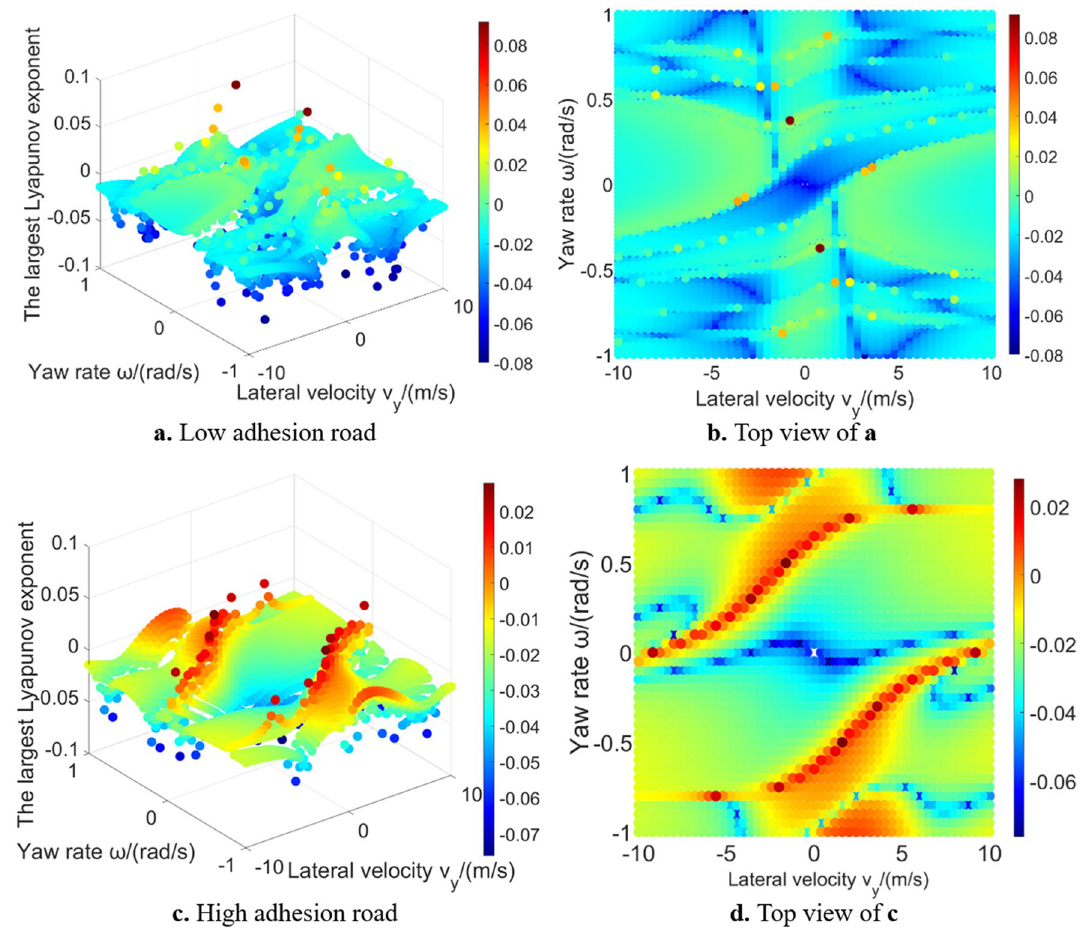
Figure 9. The largest Lyapunov exponent in the 3-DOF model global